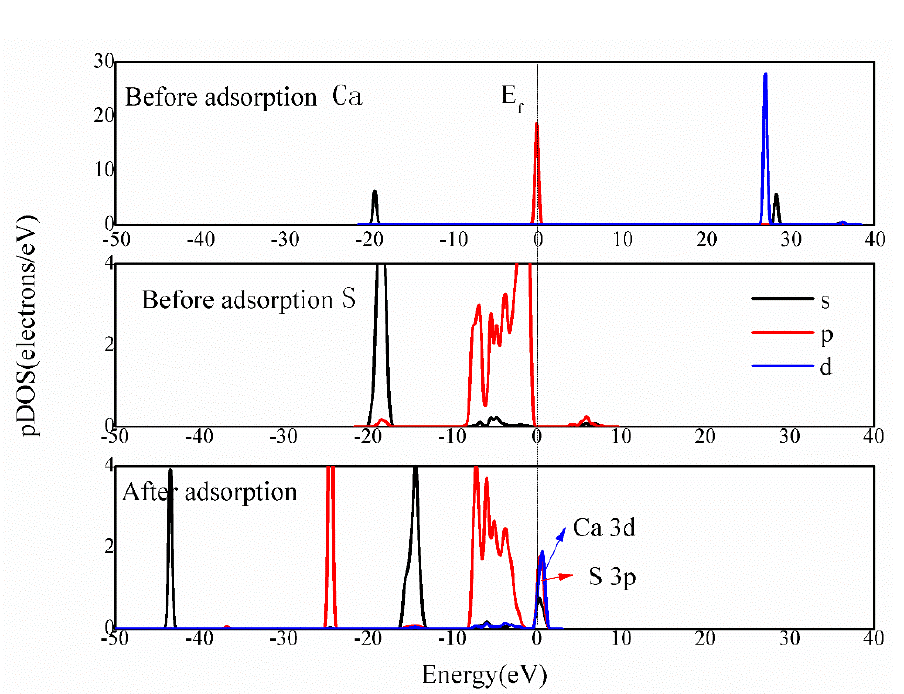
Figure 11. PDOS results of S atoms and the Ca atom before and after Ca 2+ adsorption on molybdenite (001) surface.